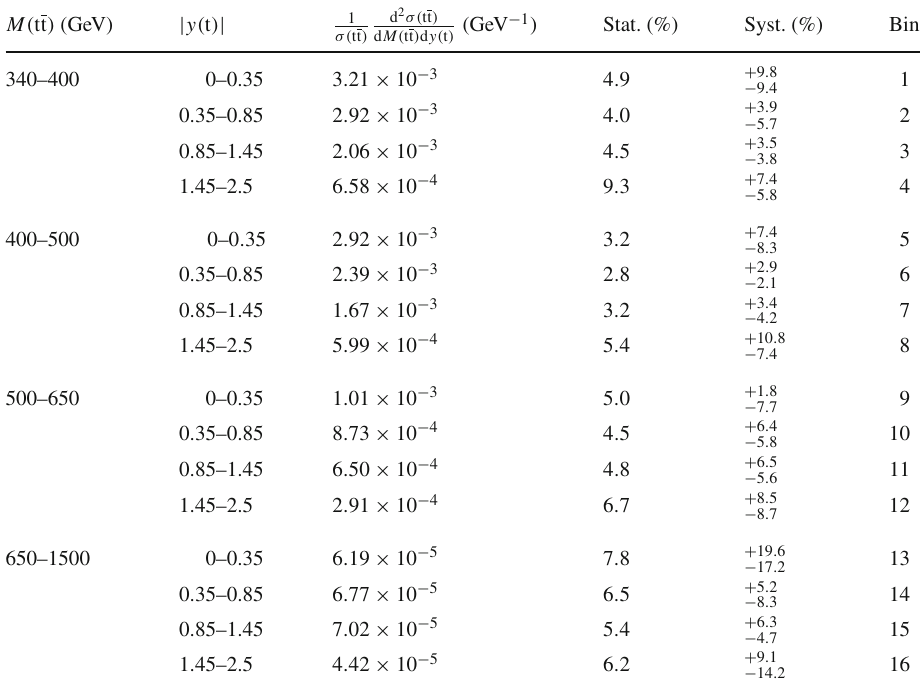
Table 8 The measured normalized tt double-differential cross sections in different bins of M ( tt ) and y ( t ) , along with their relative statistical and systematic